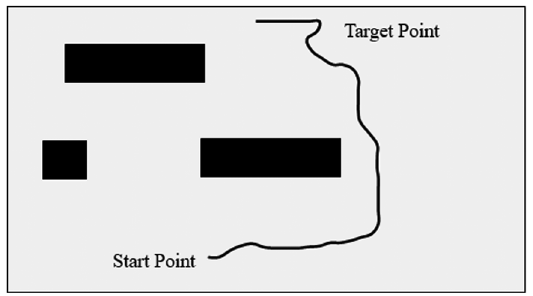
Figure 5: Voronoi skeleton diagram method planning